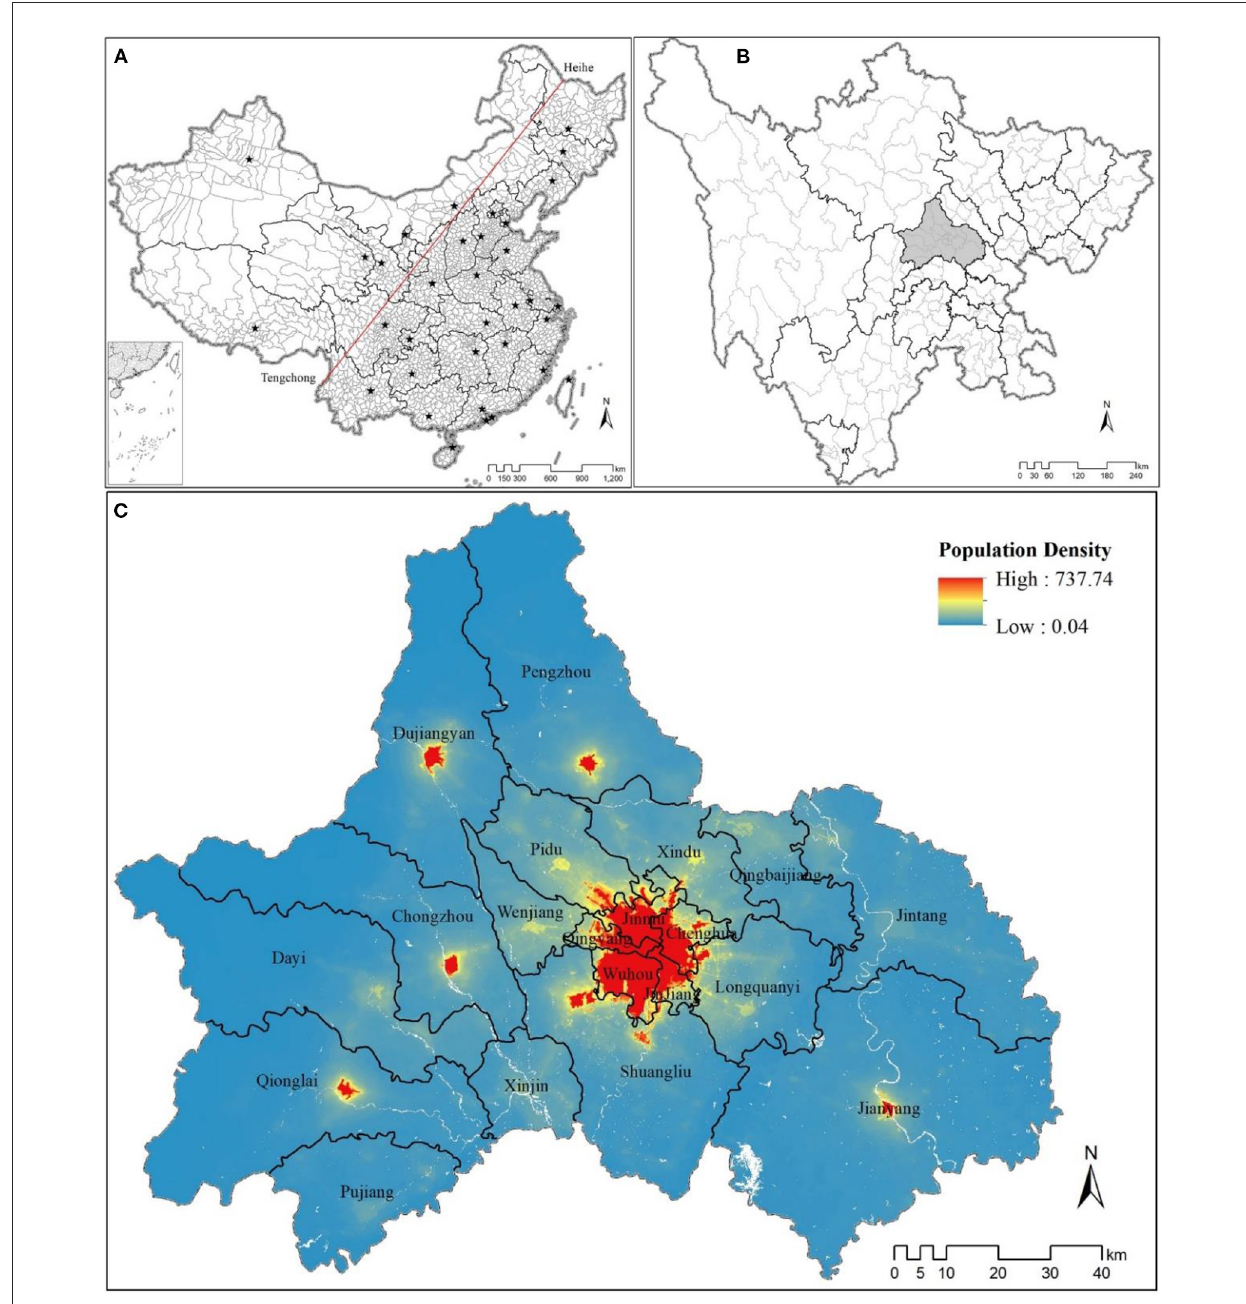
FIGURE1 (A) Mainland China, with all provincial- and county-level jurisdictions, bisected by the Heihe-Tengchong Line. (B) Sichuan Province’s prefecture and county-level jurisdictions (Chengdu in light gray), having a similar geospatial and population density breakdown corresponding to the Heihe-Tengchong Line. (C) Population density of 20 county-level jurisdictions in Chengdu (data extracted from https://www.worldpop.org/geodata/